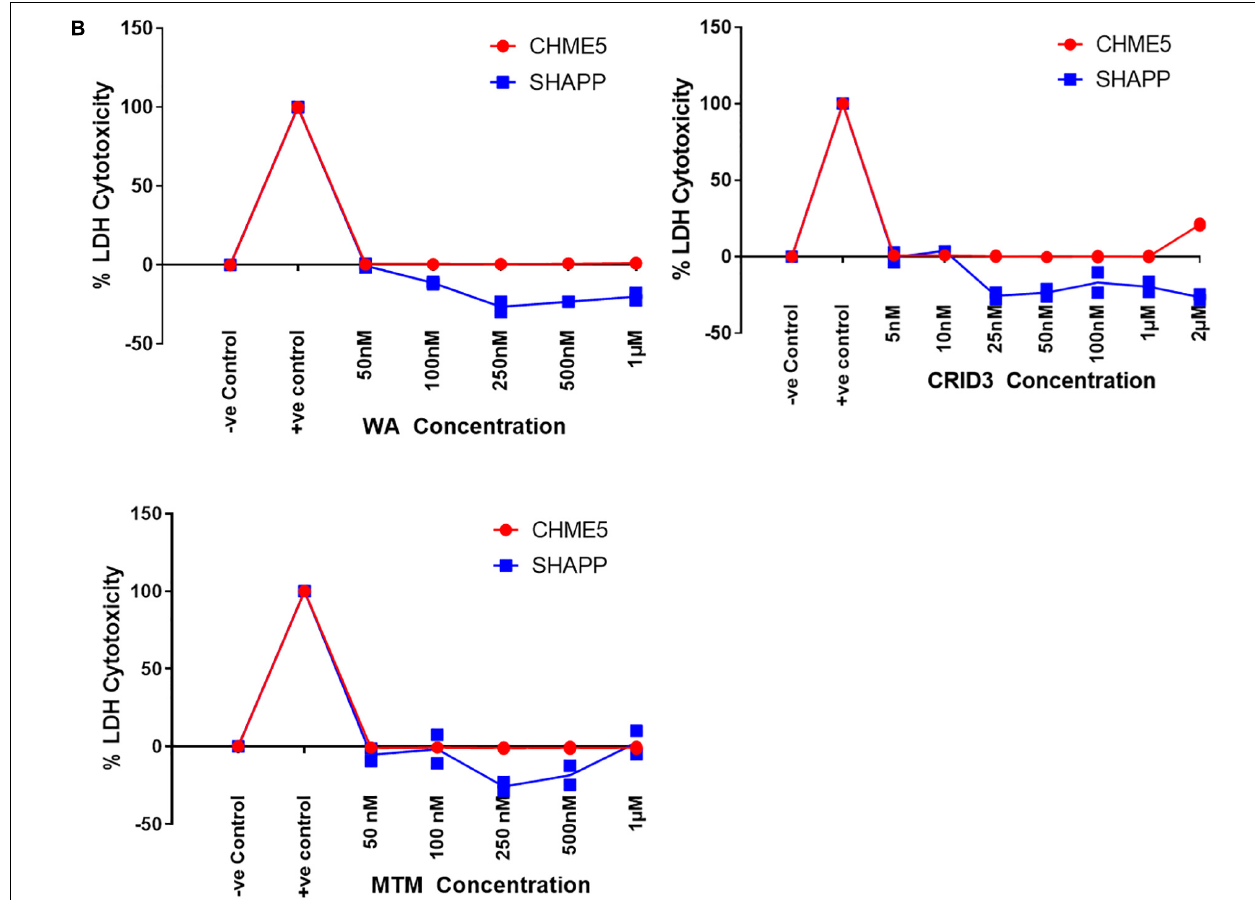
FIGURE 1 | (A) MTT cell viability assay. Amyloid precursor protein overexpressing neuronal cells (SH-APP) and microglial cells were exposed to different concentrations of withaferin A (WA) (50 nM–1 µ M) and cytokine release inhibitory drug (CRID3) (5 nM–2 µ M). After 24 h of incubation, cell viability was analyzed by using MTT assay. We have observed no significant cell death with WA up to 1 µ M and with CRID3 up to 2 µ M in both the cell types. SH-APP cells were exposed to mithramycin A (MTM, 50 nM–1 µ M) for 24 h and in MTT assay, we have not observed any significant cell death up to 1 µ M concentration. (B) LDH cytotoxicity assay. Amyloid precursor protein overexpressing neuronal cells (SH-APP) and microglial cells were exposed to different concentrations of WA (50 nM–1 µ M) and CRID3 (5 nM–2 µ M). After 24 h of incubation, cell cytotoxicity was analyzed by using the LDH cytotoxicity assay. We have observed no cytotoxicity with WA up to 1 µ M and with CRID3 up to 2 µ M in both the cell types. SH-APP cells were exposed to MTM (50 nM–1 µ M) for 24 h and we have not observed any cytotoxicity up to 1 µ M